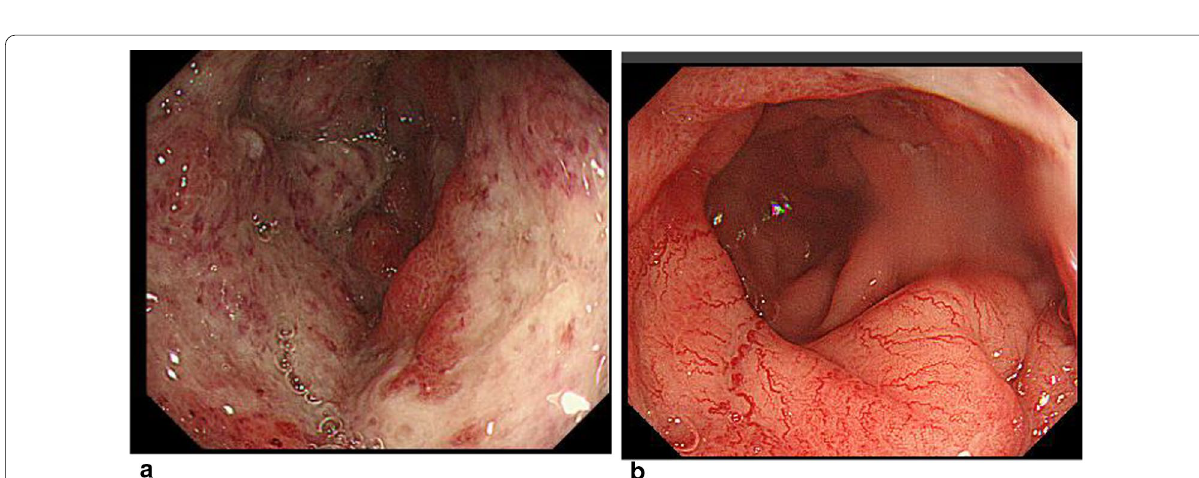
Fig. 5 Colonoscopy findings. a A circumferential ulcer is seen not adjacent to but near the anal side of the anastomosis. b The mucosa around the anal canal appears